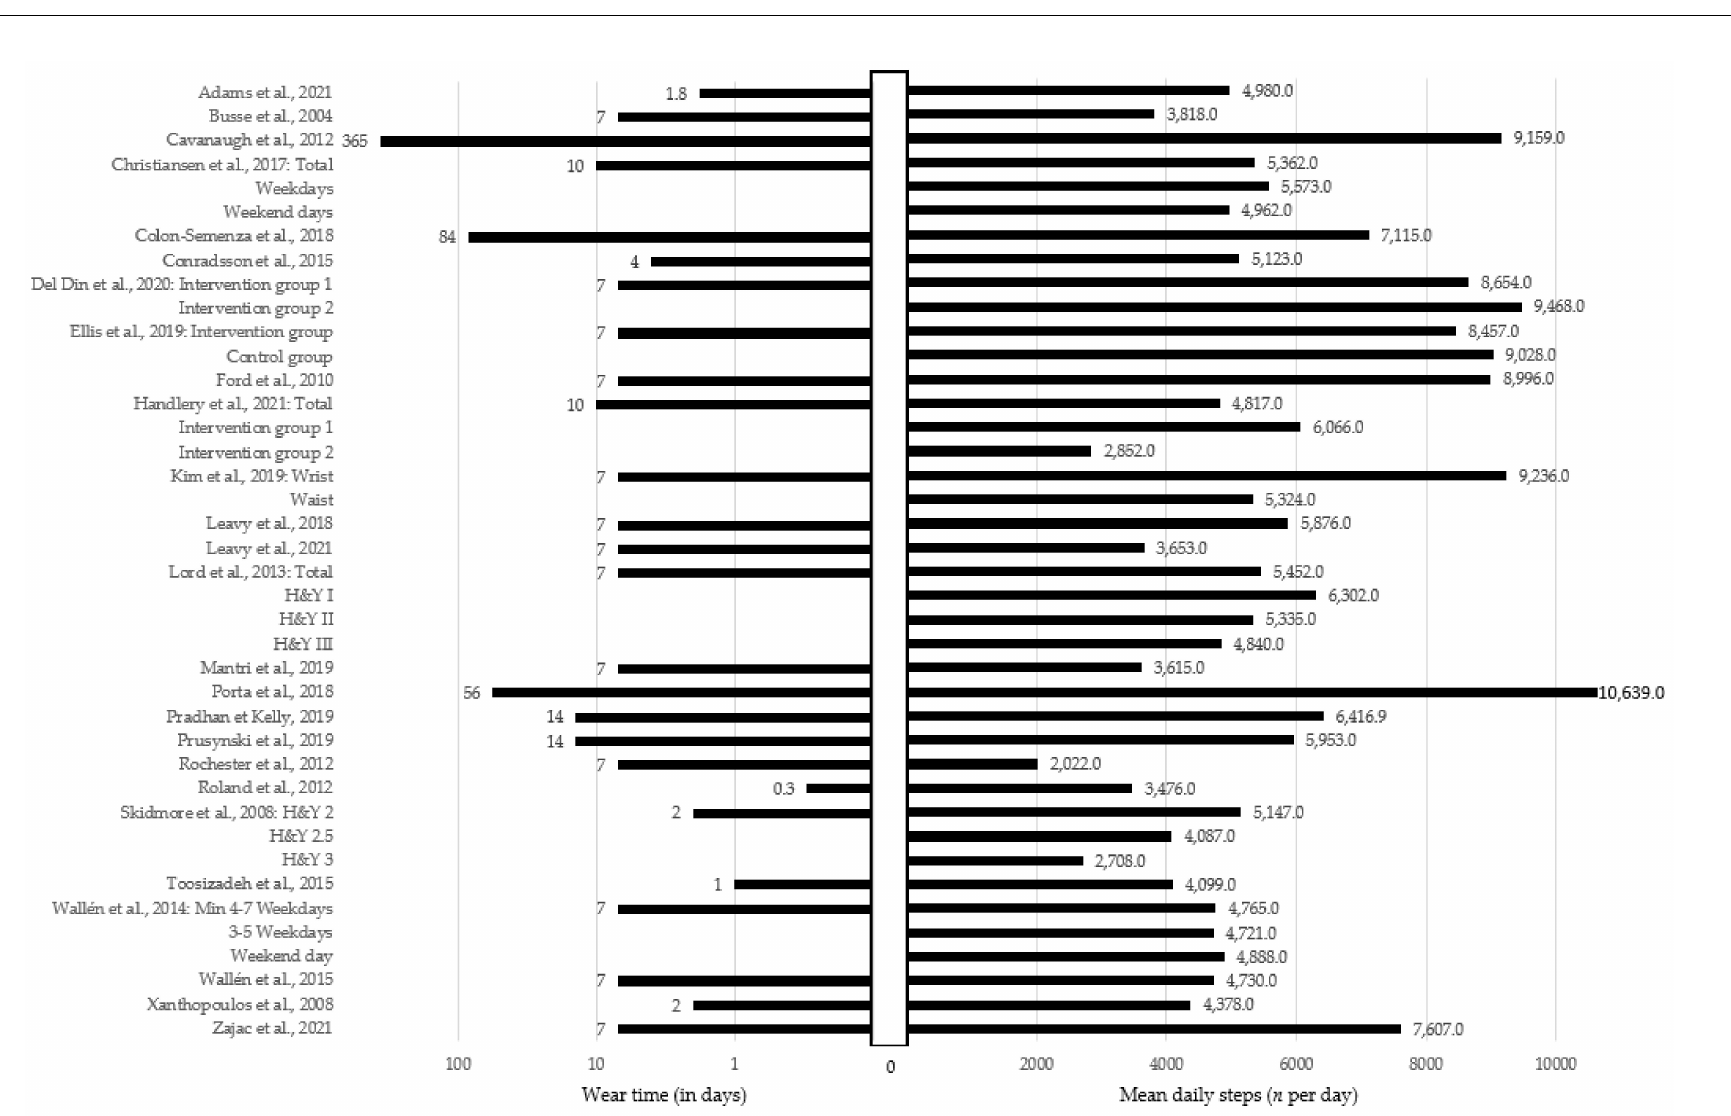
Figure A1. Wear time (in days) and mean daily step ( n per day) of included